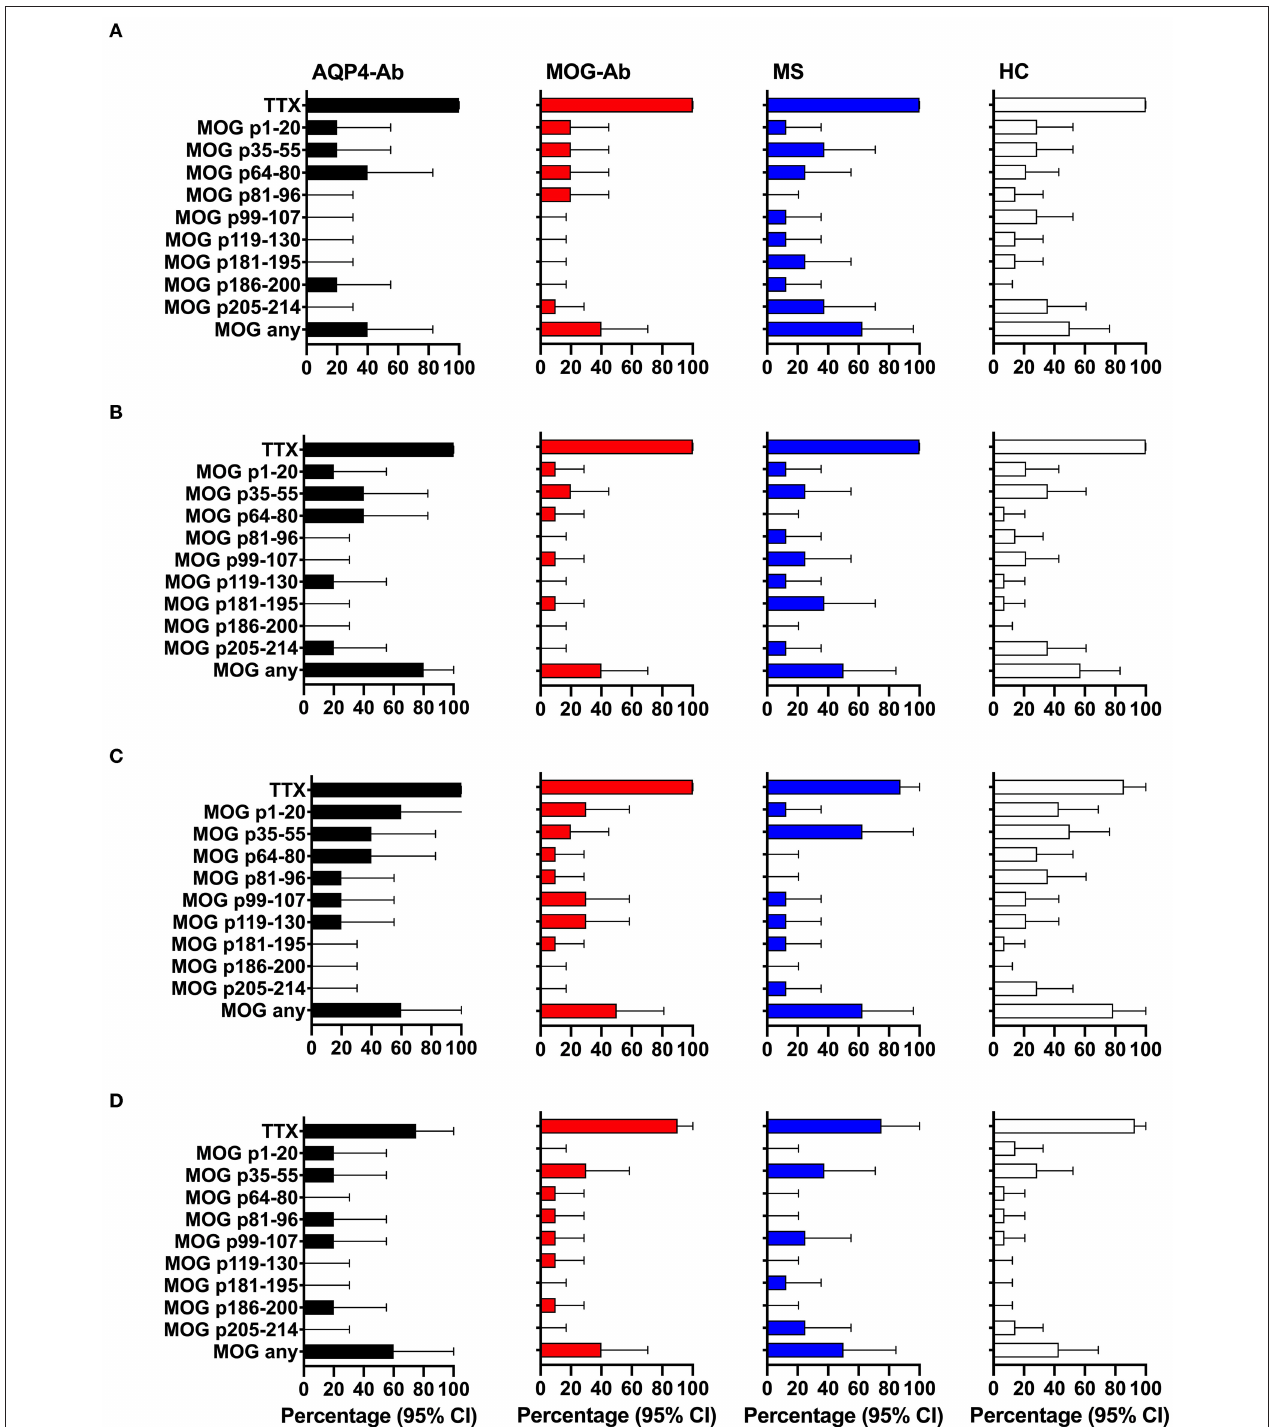
FIGURE 7 | CD4 + T-cell reactivity to MOG peptides in participants with AQP4-Ab ( n = 5), MOG-Ab ( n = 10), MS ( n = 8) and HC ( n = 14). (A) Percentage of participants with positive CD4 + T-cell proliferation (CDI ≥ 3) after challenging with respective MOG peptides and the positive control TTX. Percentage of participants with positive secretion (SI ≥ 3) of GM-CSF (B) , IFN- γ (C) and IL-6 (D) after challenging with respective MOG peptides and the positive control TTX. The 95% confidence intervals are indicated by the error bars. AQP4-Ab, aquaporin-4 antibody positive; CDI, cell division index; GM-CSF, granulocyte-macrophage-colony- stimulating factor; HC, healthy controls; IFN, interferon; IL, interleukin; MOG-Ab, myelin oligodendrocyte glycoprotein antibody positive; MS, multiple sclerosis; SI, stimulation index; TTX, tetanus toxoid.